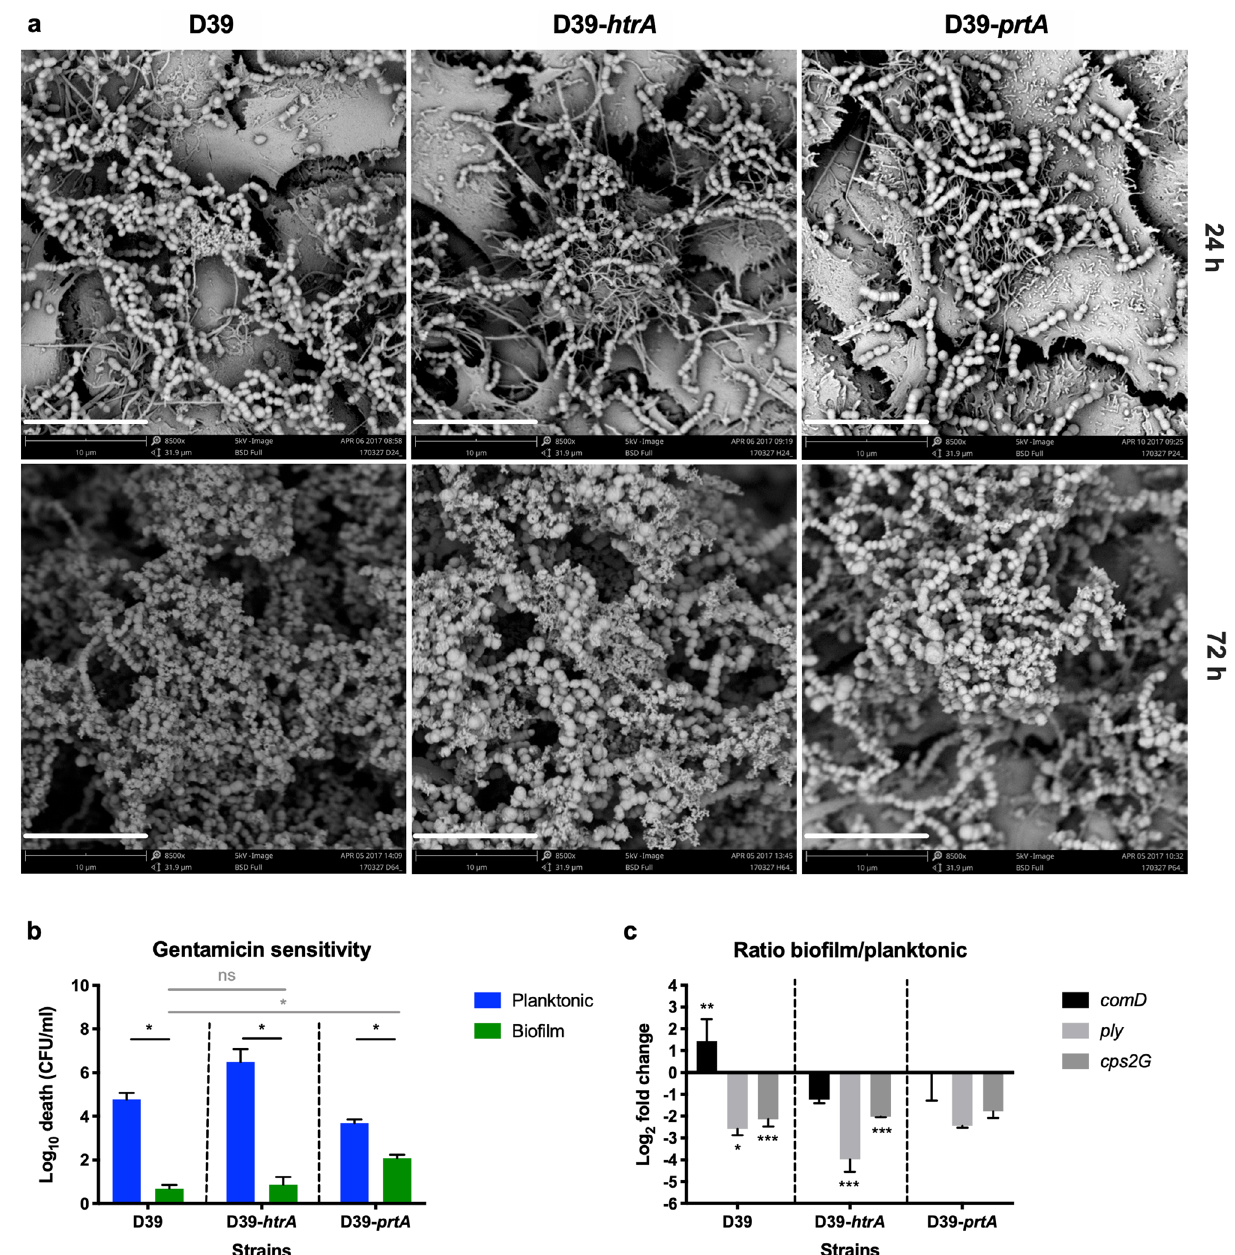
Figure 4. Biofilm formation by protease mutants. ( a ) Biofilm morphology was detected at 24 h (upper panels) and 72 h (lower panels) by scanning electron microscopy. The white scale bar represents 10 μm. ( b ) Wild- type and mutant D39 biofilm and planktonic bacteria were exposed to 500 μg/ml gentamicin for 3 h and the sensitivity to the antibiotic was determined by viable plate counts. ( c ) Relative gene expression of wild-type and mutant D39 as a ratio of biofilm bacteria to broth-grown planktonic bacteria. Data represent triplicates from four separate experiments, with the mean and SEM displayed. Statistical analysis was performed using Mann– Whitney U test (black) or Kruskal–Wallis test with Dunn’s multiple comparisons test (grey) ( b ) and two-way ANOVA with Dunnett’s multiple comparisons test ( c ); ns not significant, ** P < 0.01, *** P <